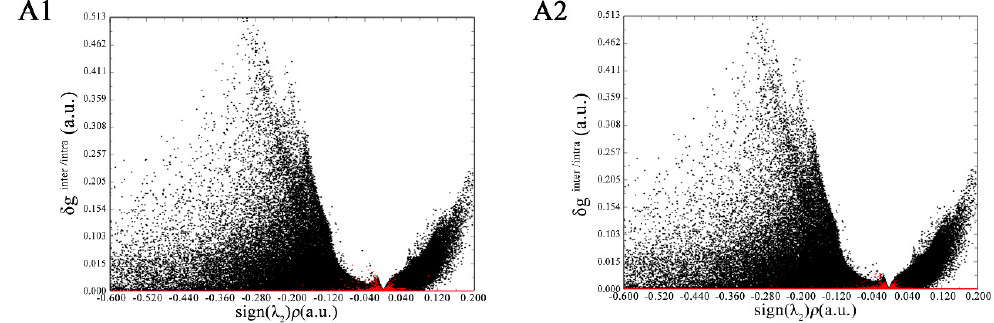
Figure 3. Visual scatter maps between δ ginter and δ gintra vs. sign( λ 2 ) p of myricetin ( A1 ) and dihydromyricetin ( A2 ) with α -glucosidase.